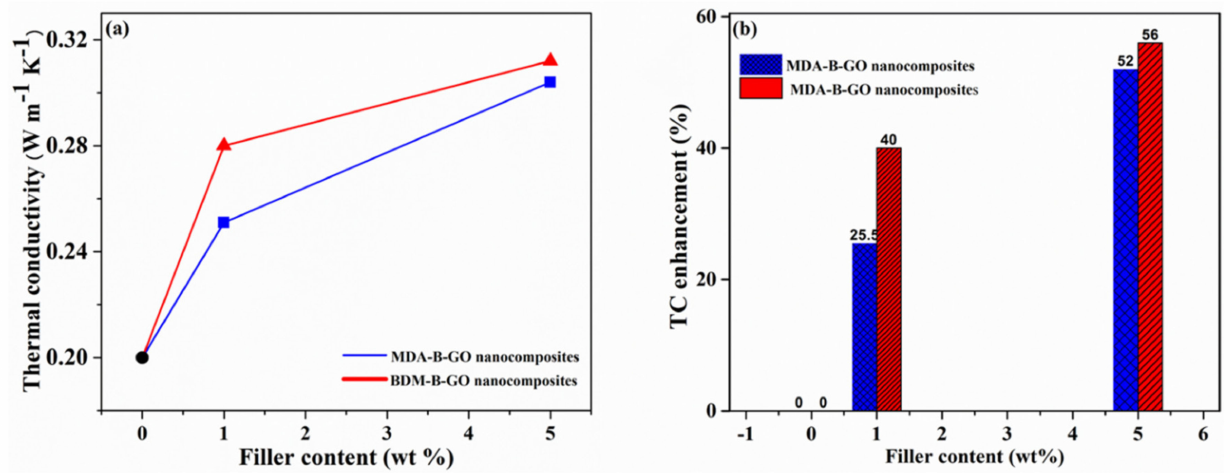
Figure 10. ( a ) Thermal conductivities of nanocomposites ( b ) % Thermal conductivity enhancement in